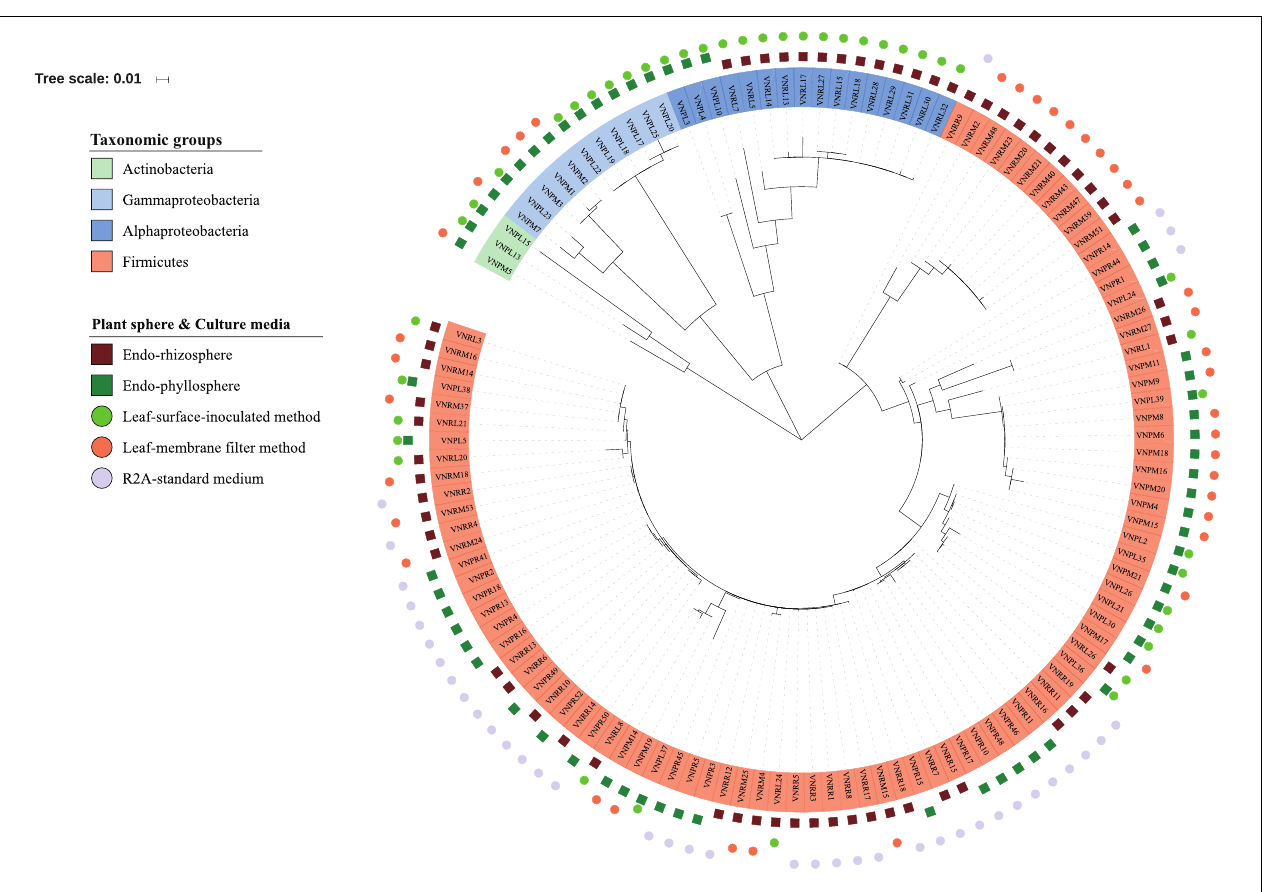
FIGURE 4 | Phylogenetic tree of 16S rRNA gene sequences of the 122 isolates obtained. The colored labels indicate the taxonomic groups (Actinobacteria, Gammaproteobacteria, Alphaproteobacteria, Firmicutes), plant compartments (endorhizosphere (cid:4) and endophyllosphere (cid:4) ), and culture media (leaf-surface-inoculation method • , leaf-membrane filter method • , and standard R2A culture medium •